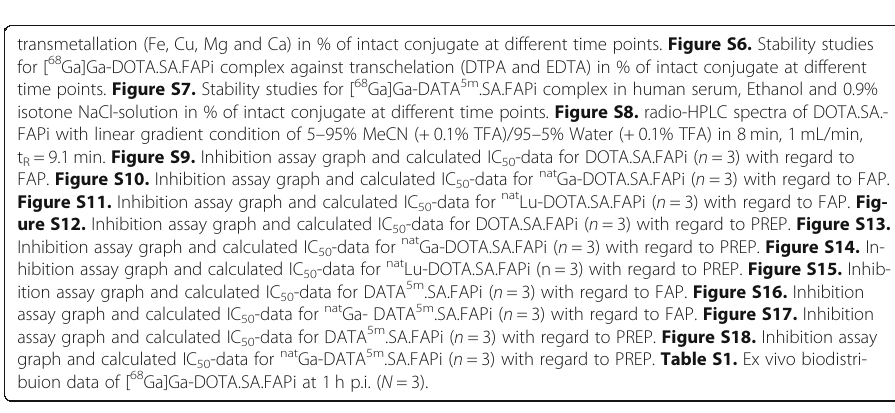
Abbrevations DATA : 2,2 ′ -(6-((carboxymethyl)amino)-1,4-diazepane-1,4-diyl) diacetic acid).; DATA 5m -3 t Bu: 5-[1,4-bis tertbutoxycarbonylmethyl-6-(tert-butoxycarbonylmethyl-methyl-amino)-[1,4] diazepan-6-yl]-pentanoic acid; DOTA: 1,4,7,10-Tetraazacyclododecane-1,4,7,10-tetraacetic acid; DTPA: Cyclohexyldiethylene-triaminepentaacetic